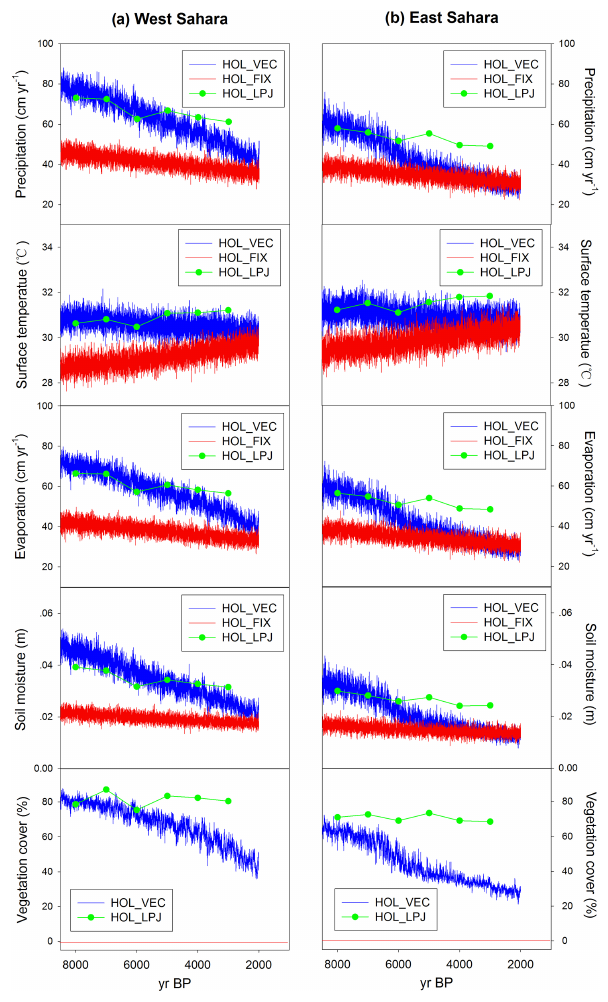
Figure 4. Evolution of western (a) and eastern (b) North African precipitation, surface temperature, evaporation, soil moisture, and total vegetation cover during the Holocene. The longitudinal bound- aries were between 10 ◦ W–10 ◦ E (western part) and 10–35 ◦ E (east- ern part), both with latitudinal limits at 15 and 30 ◦